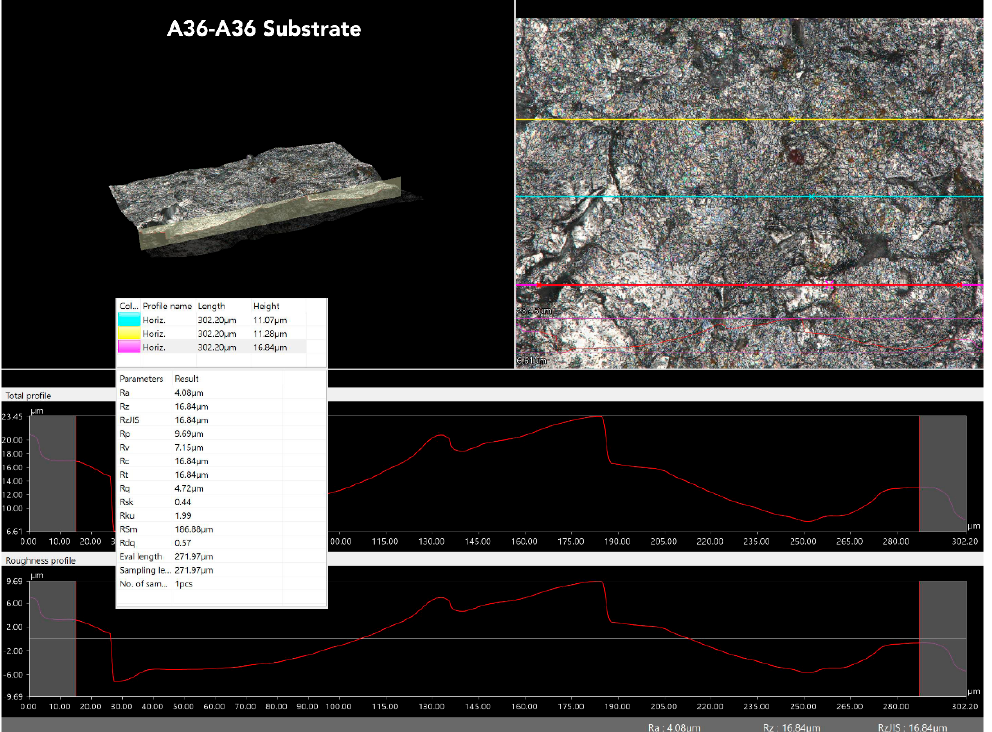
Figure 17. The images of the shot blasted surfaces: ( a ) 309L cladding; ( b ) A36—A36 substrate.